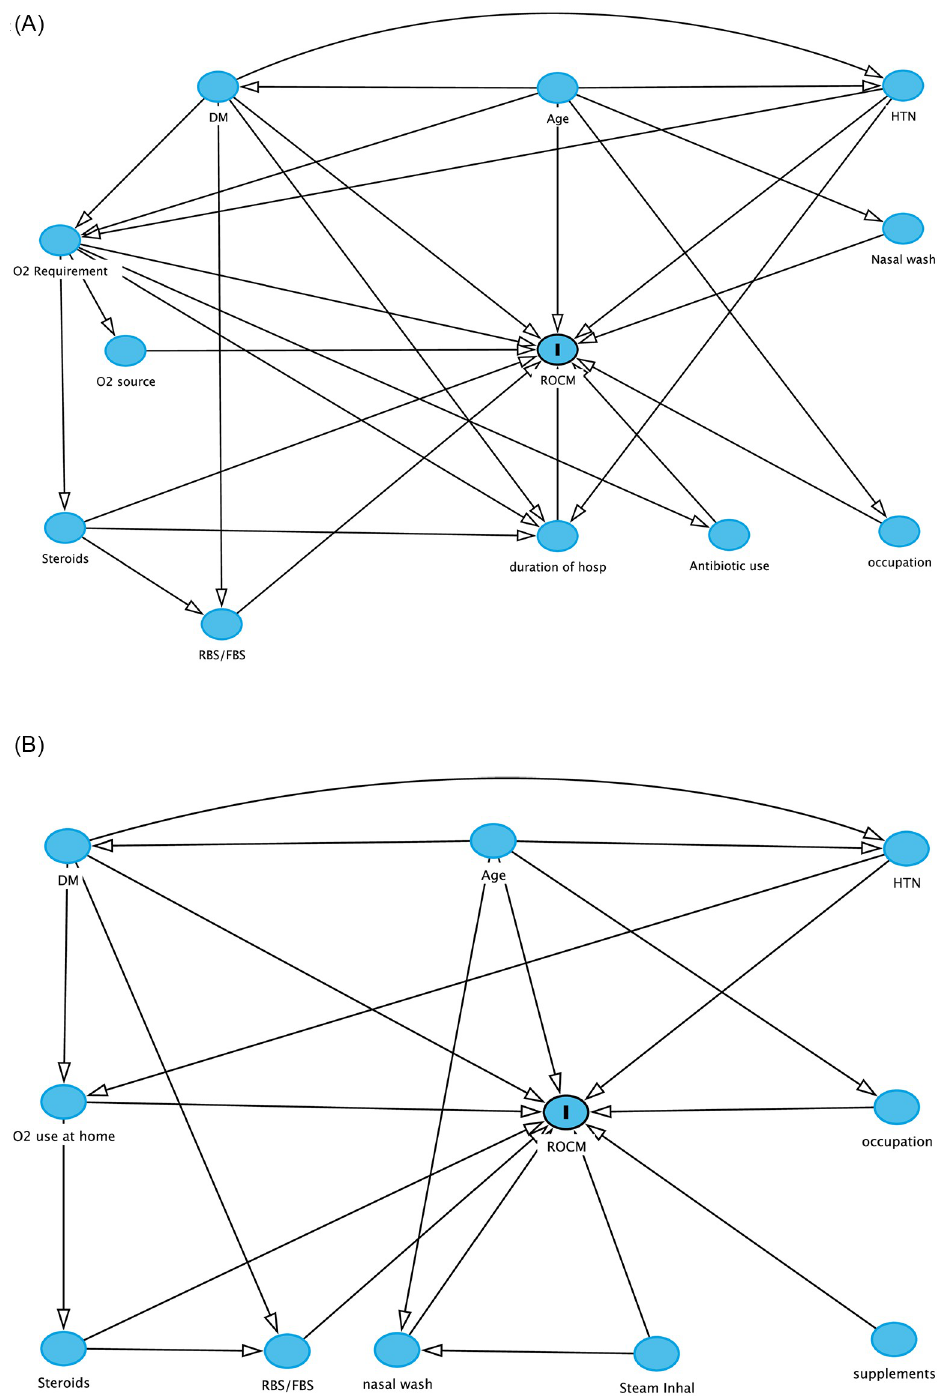
Fig 1. Directed acyclic graph of Post COVID-19 rhino orbito cerebral mucormycosis for (a) ever-hospitalised and (b) never-hospitalised patients.